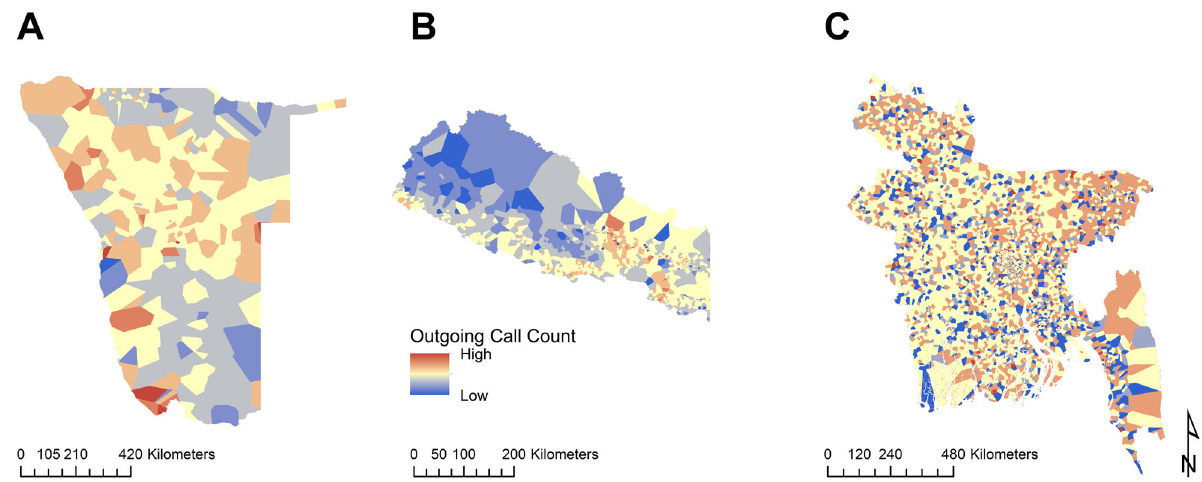
Fig. 1 Mean outgoing call count per cell tower for Namibia ( A ), Nepal ( B ), and Bangladesh ( C ). The coverage areas for the cell towers are approximated by Voronoi